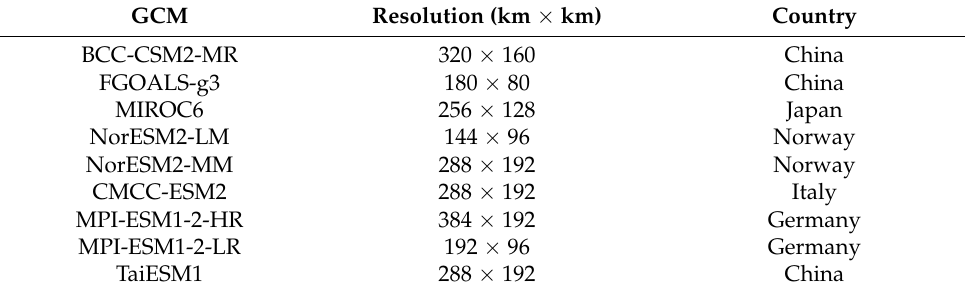
Table 1. Basic information of 9 GCMs in CMIP6.